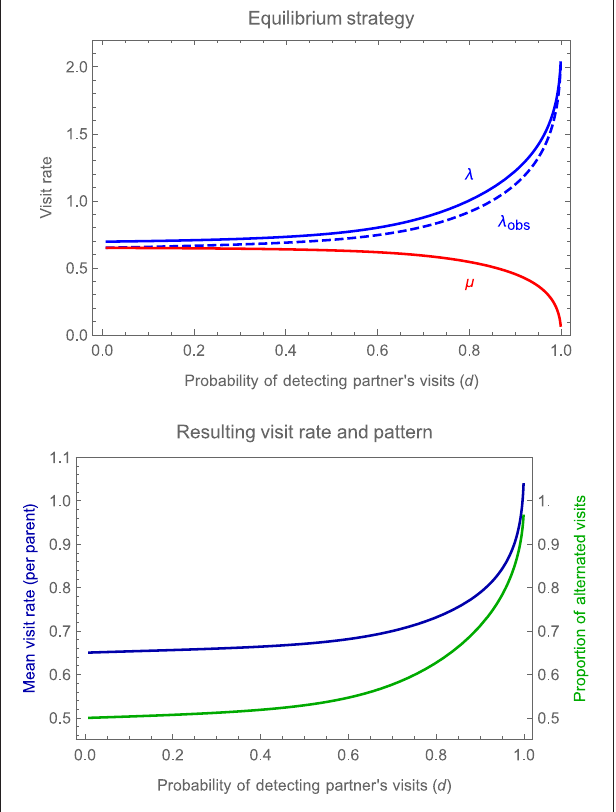
FIGURE 5 | Changes in the equilibrium alternating strategy, for the illustrative symmetrical case considered in Figure 4 , as one varies the probability d of detecting a partner’s visits (assuming that this is the same for both parents, i.e., that d f = d m = d ); other parameter values and payoffs are as specified in the legend to Figure 4 . The upper panel shows the equilibrium values of λ (a focal individual’s visit rate immediately after it detects a visit by its partner), plotted in blue, and µ (a focal individual’s visit rate immediately after visiting the young itself), plotted in red, as a function of the probability of detecting a partner’s visits ( d ); also shown is λ obs , a focal individual’s visit rate immediately after a fully-informed human observer records a visit by its partner (allowing for the possibility that the focal individual itself may fail to detect the partner’s visit). The lower panel shows the resulting overall mean visit rate by a parent, plotted in blue, and the proportion of alternated visits, plotted in green, again as a function of the probability of detecting a partner’s visits ( d ).